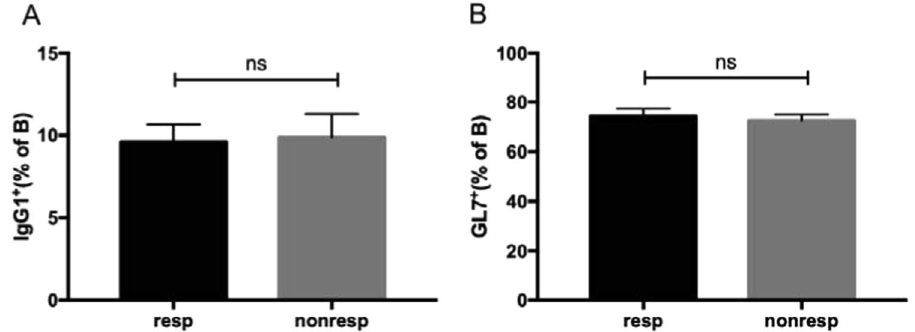
Figure 7. The equal functionality of T FH cells between the responder and non-responder. CXCR5 + CD4 + CD25 − T FH cells sorted from the responder group and non-responder group in week 12 was cultured with CD19 + B cells from the responder group along with anti-CD3 and anti-IgM for six days. B cells were intracellularly stained for IgG1 and surface stained for GL7. The percentage of IgG1 + ( A ) andGL7 + ( B ) cells was calculated in CD19 + B cells. Data were from three independent experiments and the mean ± SEM were shown. ns, no